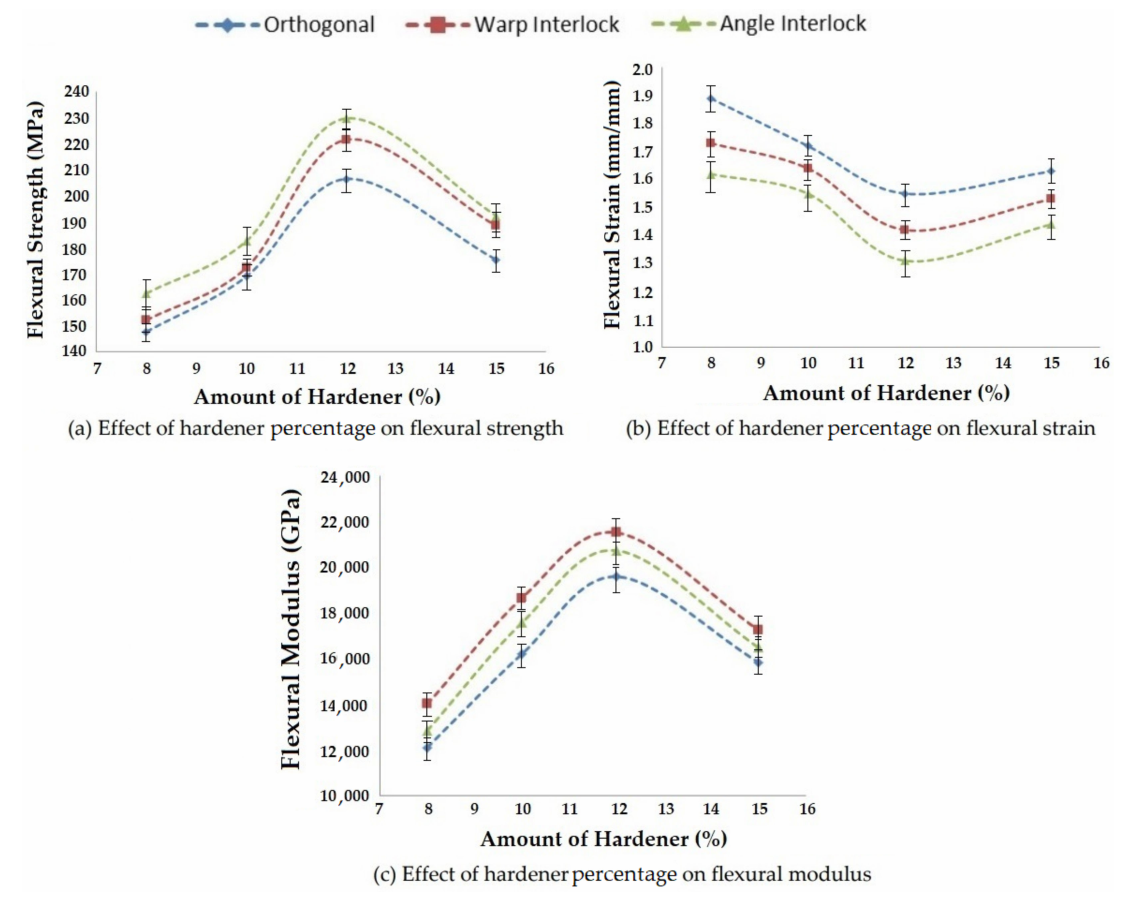
Figure 19. Effect of the amount of hardener on the flexural properties of 3D woven